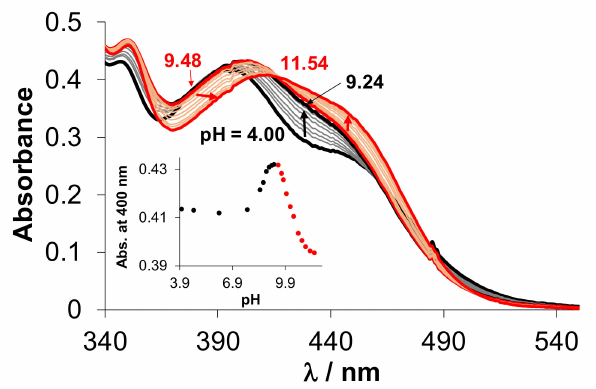
Figure 5. UV-vis spectra of the RuCym–HQCl-D-hPro complex at various pH values. Inserted figure shows the absorbance changes at 400 nm plotted against the pH. (Abs. stands for absorbance and arrows indicate the direction of the changes of the spectra with increasing the pH in the different pH ranges (black: between 4.00–9.24, red: 9.48–11.54.) { c RuCym = c ligand = 116 µ M; I = 0.2 M KNO 3 ; T = 25.0 ◦ C; (cid:96) = 1